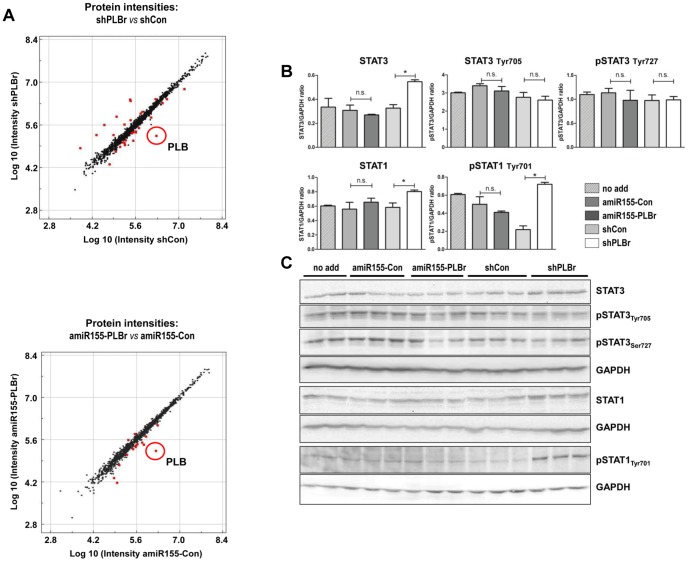
Alterations in the global protein pattern in scAAV6-amiR155-PLBr and scAAV6-shPLB transduced cardiomyocytes assessed by shot gun proteomics and validation by Western Blot.(A) Scatter plot of protein intensities of cardiomyocytes (CM) 14 days after transduction with 25×103 vg/c of scAAV6-shPLBr (shPLBr), scAAV6-amiR155-PLBr (amiR155-PLBr) or the control vectors scAAV6-shCon (shCon) and scAAV6-amiR155-Con (amiR155-Con). Each dot represents one protein. Red dots represent proteins displaying significantly different levels in comparison to control experiment (fold change >1.5, p<0.01). PLB is phospholamban protein. (B and C) Western Blot analysis of STAT1 and STAT3. CM were transduced and analyzed at 14 days after transduction as in A. (B) Quantitative analysis of three bioreplicates per assay. STAT-specific signal intensities were normalized to GAPDH as loading control. (C) Western Blot images of total and phosphorylated STAT1 and STAT3 were analyzed on 3 separate membranes. GAPDH was detected as a house keeping protein on each membrane. *p<0.05 significant intergroup difference as indicated; n.s., not significantly different.